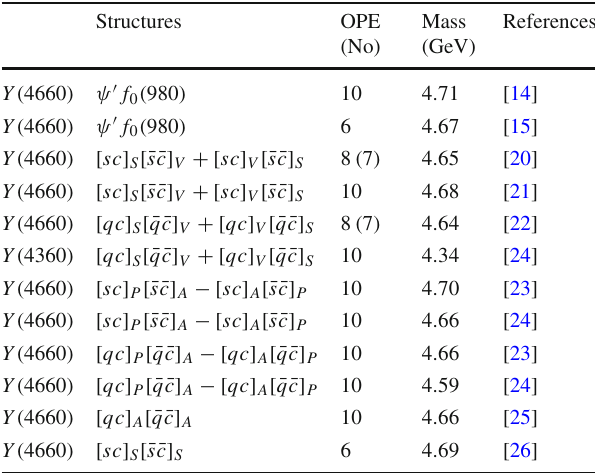
Table 2 The masses from the QCD sum rules with different quark structures, where the OPE denotes truncations of the operator product expansionuptothevacuumcondensatesofdimension n ,theNodenotes the vacuum condensates of dimension n (cid:4) are not included Structures OPE Mass (No)